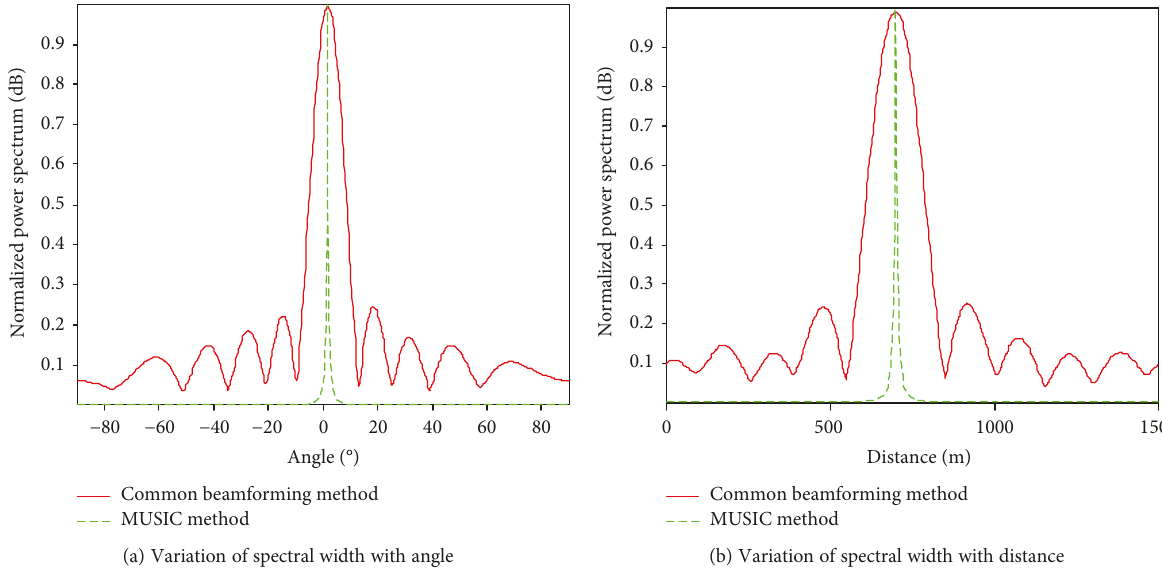
Figure 4: Spectrum comparison of two methods after